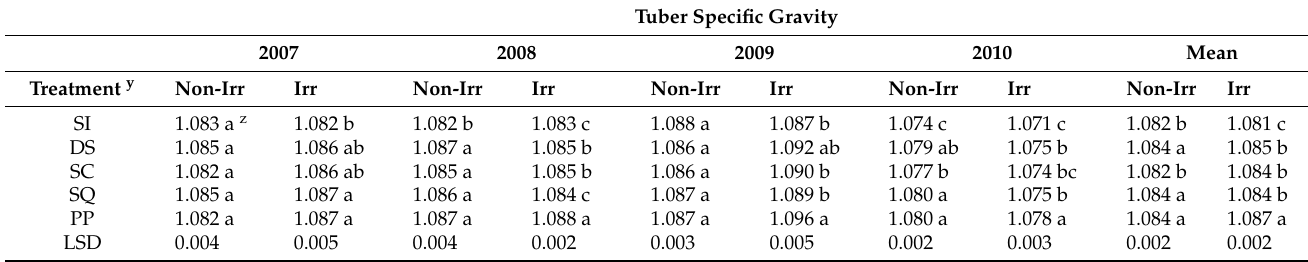
Table 4. Effect of different cropping systems on tuber specific gravity over four field seasons (2007–2010) under irrigated (Irr) and non-irrigated (Non-irr)